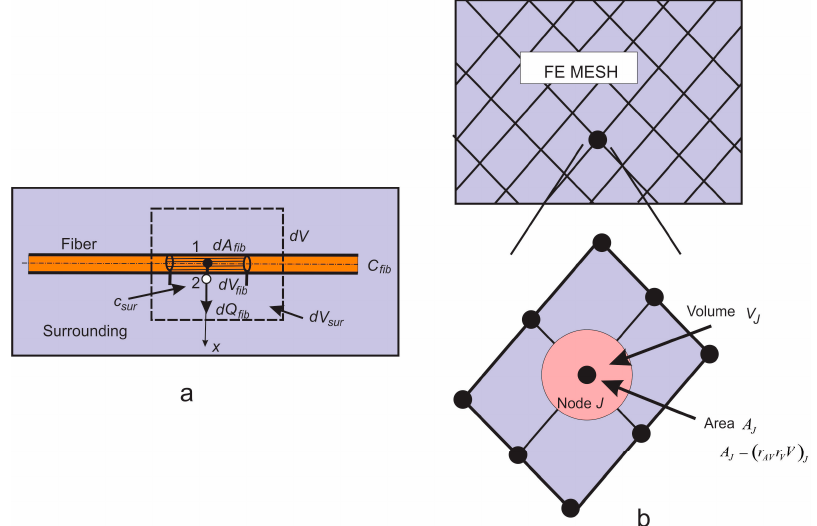
Figure 5. ( a ) Diffusion from fiber surface dA fib , which corresponds to the fiber volume dV fib and total volume dV ; dV sur is the volume occupied by the surrounding medium; ( b ) Corresponding smeared model.